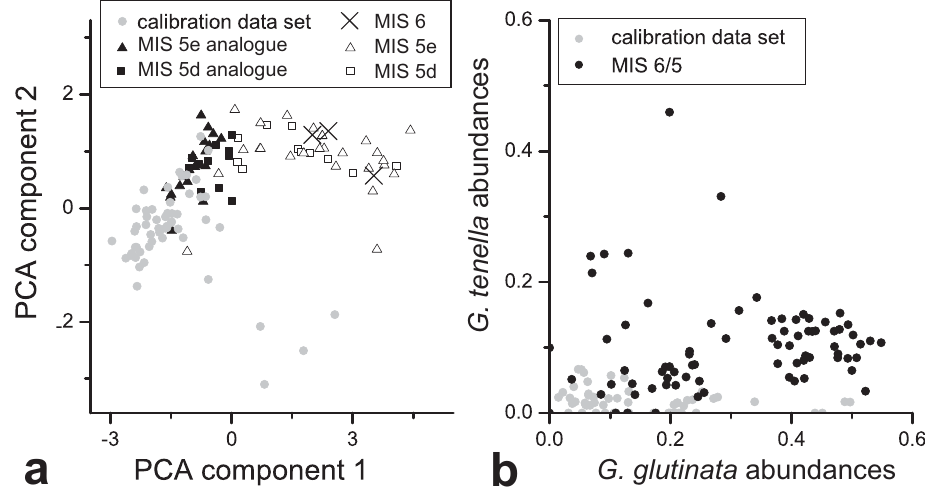
Fig. 4. Comparison of KL9 foraminiferal faunal assemblage data of MIS 6-5d and the calibration data set (grey filled circles). Left: analogy analyses of the most abundant species (according to Siccha et al., 2009). Plotted is PCA component 1 vs. PCA component 2. Black symbols indicate samples from the periods ∼ 129–121ka BP and ∼ 112–108ka BP, which are considered as analogous to modern samples. Open symbols indicate non-analogue samples. Right: G. glutinata vs. G. tenella relative abundances.